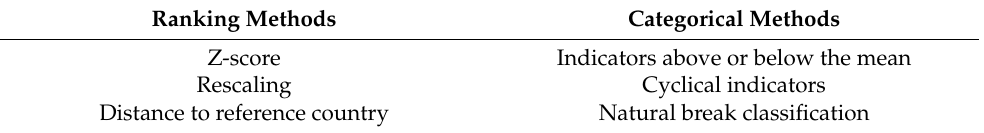
Table 2. Data standardization methods